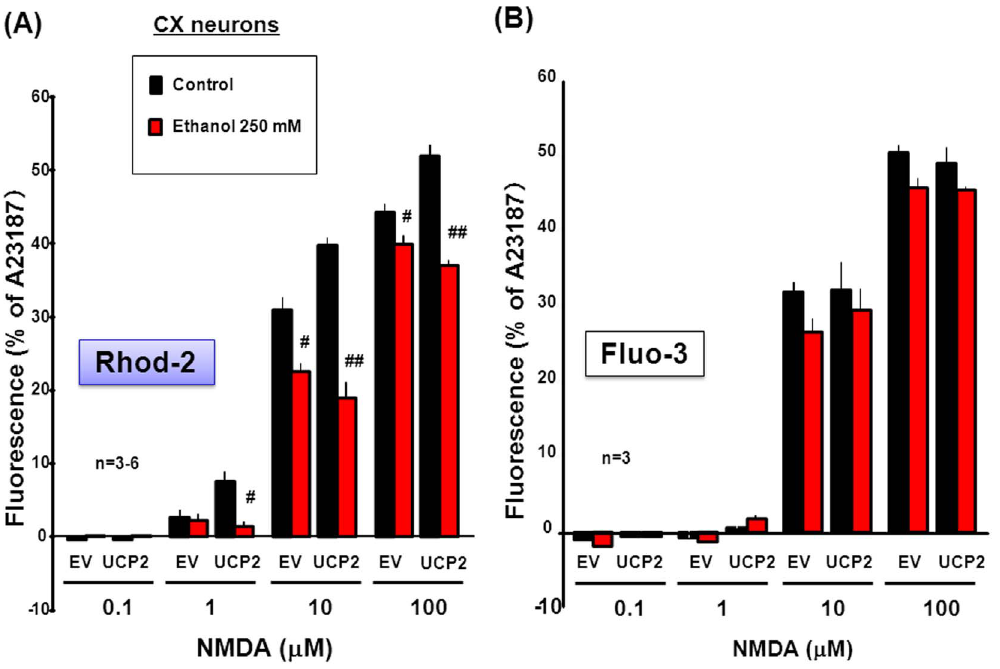
Figure 4. Effects of ethanol on Rhod-2 and Fluo-3 fluorescence in cultured neurons with UCP2 overexpression. Murine neocortical neurons were cultured for 4 days, followed by infection with lentiviral UCP2 or EV expression vector and subsequent further culture for an additional 4 days. Cells were then loaded with either (A) Rhod-2 or (B) Fluo-3, followed by cumulative addition of NMDA at concentrations of 0.1 to 100 m M in either the presence or absence of 250 mM ethanol. Values are percentages over the maximal fluorescence by A23187 in 3–6 independent determinations. # P , 0.05, ## P , 0.01, significantly different from the value obtained in cells not exposed to ethanol. Statistical significance was determined according to the 2-way ANOVA test analysis.